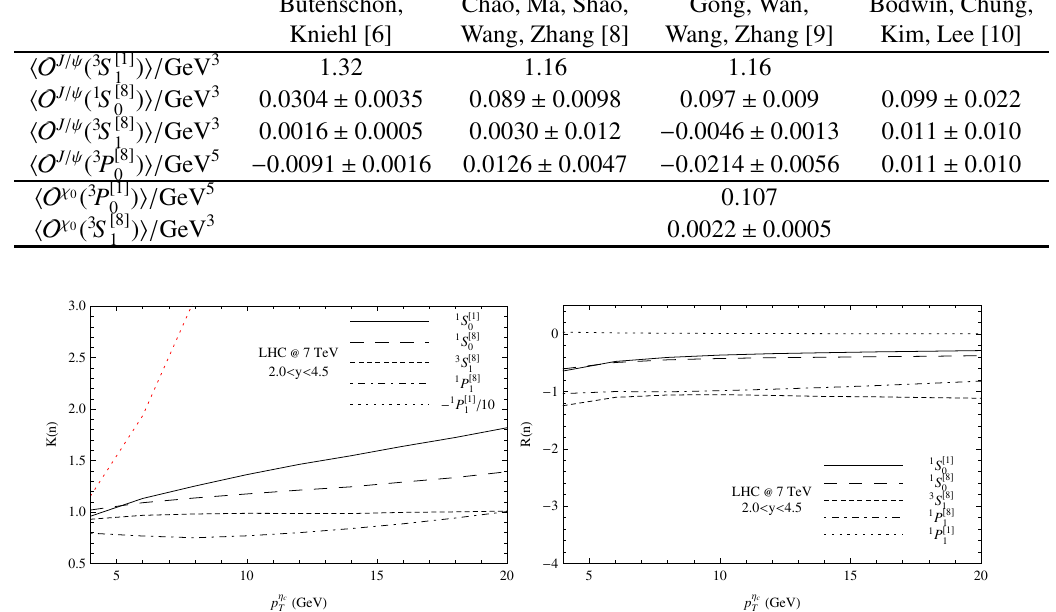
/ d σ c ¯ c [ n ] measuring the NLO LO